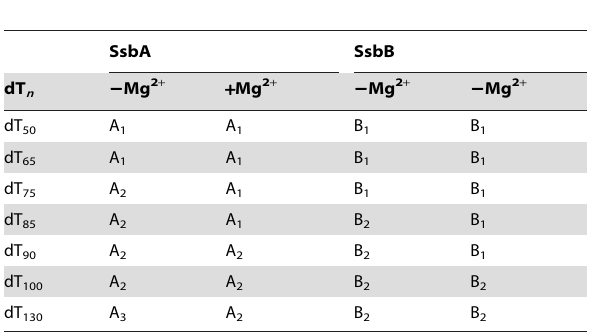
These results were derived from the experiments shown in Figures 2–5 and additional experiments (gels not shown), and indicate the highest order complexes that were observed when the indicated dT n oligomers were mixed with an excess concentration of SsbA or SsbB protein, in the absence or presence of 10 mM Mg 2 + (the notations A n and B n indicate the number of SsbAs or SsbBs